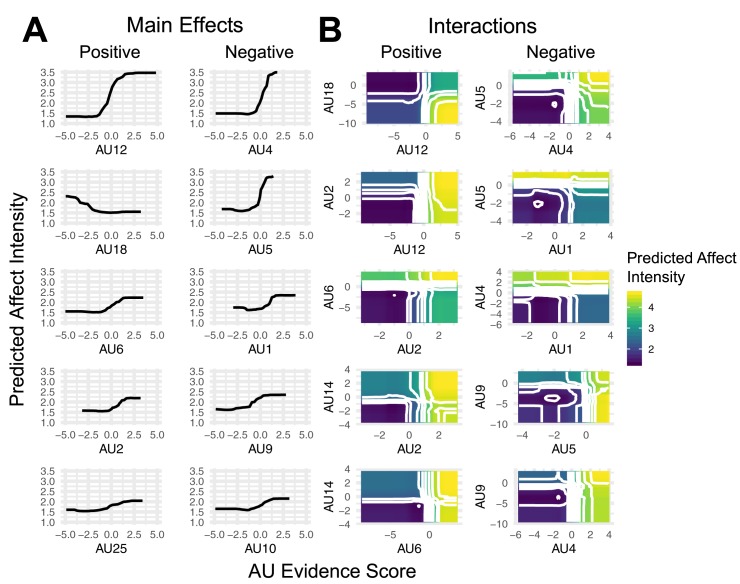
Directionality of main and interactive effects.Partial dependence plots of the 5 most important main and interactive effects for both positive and negative affect intensity ratings. Partial dependence indicates the predicted affect intensity while integrating over all other AUs. Panel (A) shows the directionality of main effects, where increasing (decreasing) values indicate positive (negative) effects as AU presence increases. Panel (B) shows directionality of interactive effects, where warmer (cooler) colors indicate higher (lower) affect intensity ratings given specific combinations of AU presence scores on the x- and y-axes.